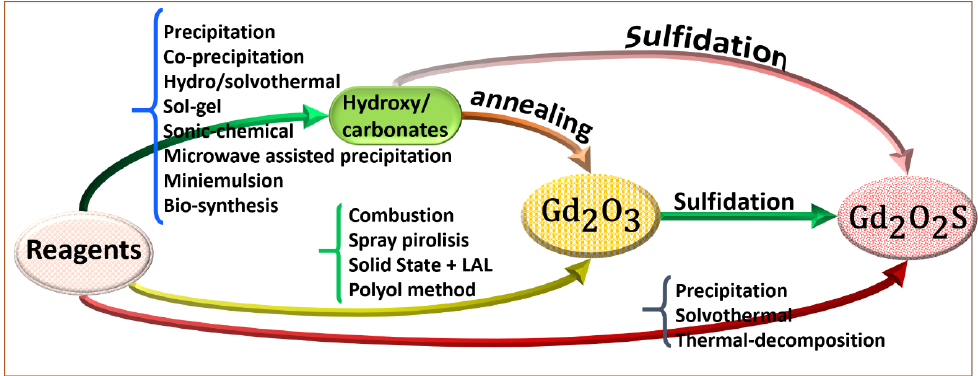
Figure 5. Synthesis routes to produce gadolinium oxides and/or oxysulfide materials at the micro and nano level.